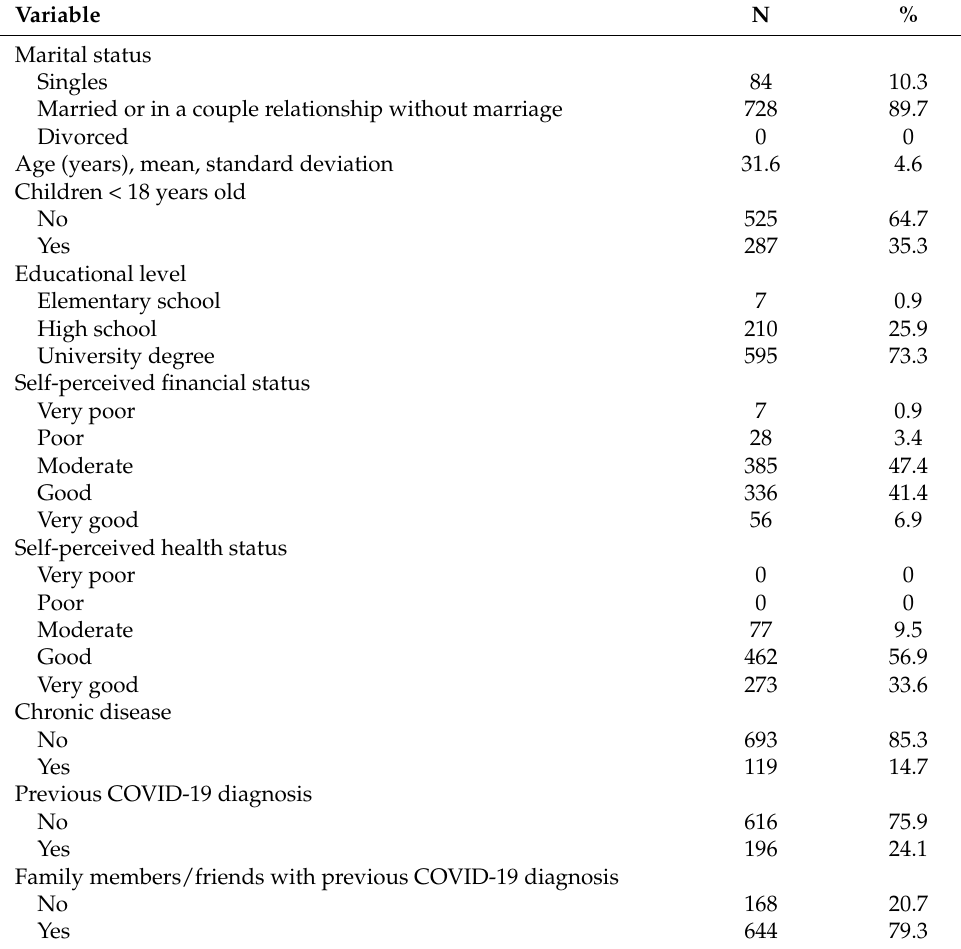
Table 1. Socio-demographic characteristics of the pregnant women (N =